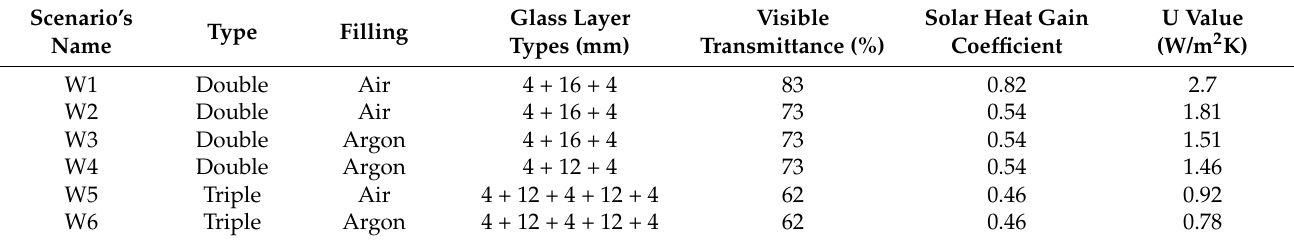
Table 6. The alternative scenarios to transparent area of the mosque